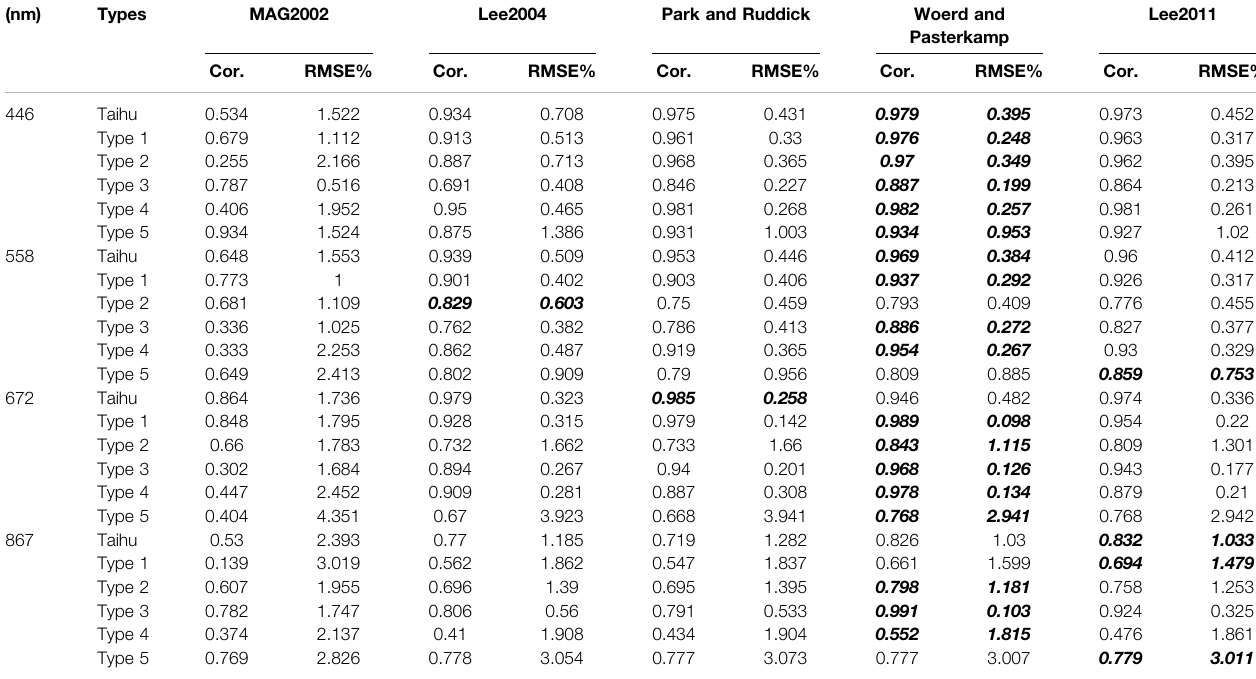
TABLE 3 | Fitting result statistics for fi ve models for Taihu Lake as a whole and for fi ve water types. The bold-italic values mean the best results in every case. (nm)